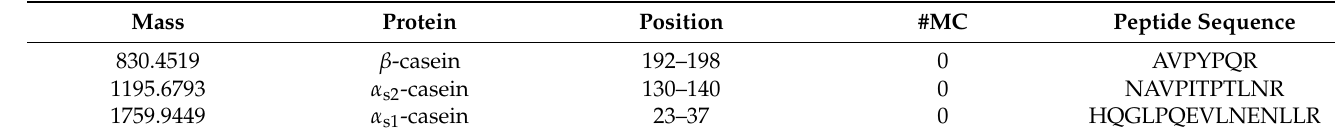
Figure 1. Peptide spectra of α -casein, β -casein, cow milk, and goat milk based on MALDI-TOF MS with DHB as matrix. Table 1. The parameters of selected specific peptides.